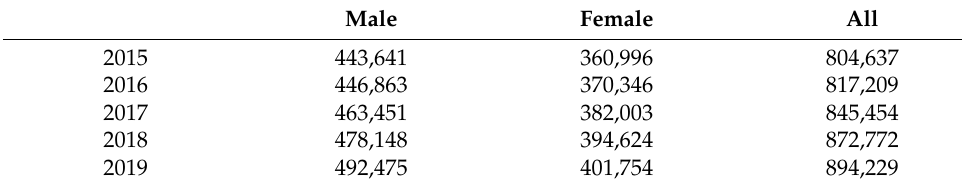
Table 1. Active workers included in the study by gender, age and calendar year. Male Female